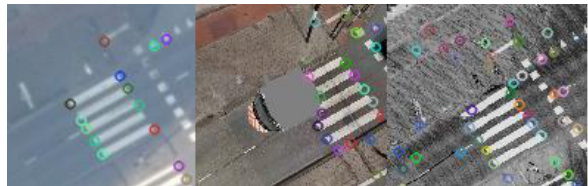
Figure 8 Förstner keypoints detected in aerial image (left), panoramic image (centre) and MLS intensity image (right)